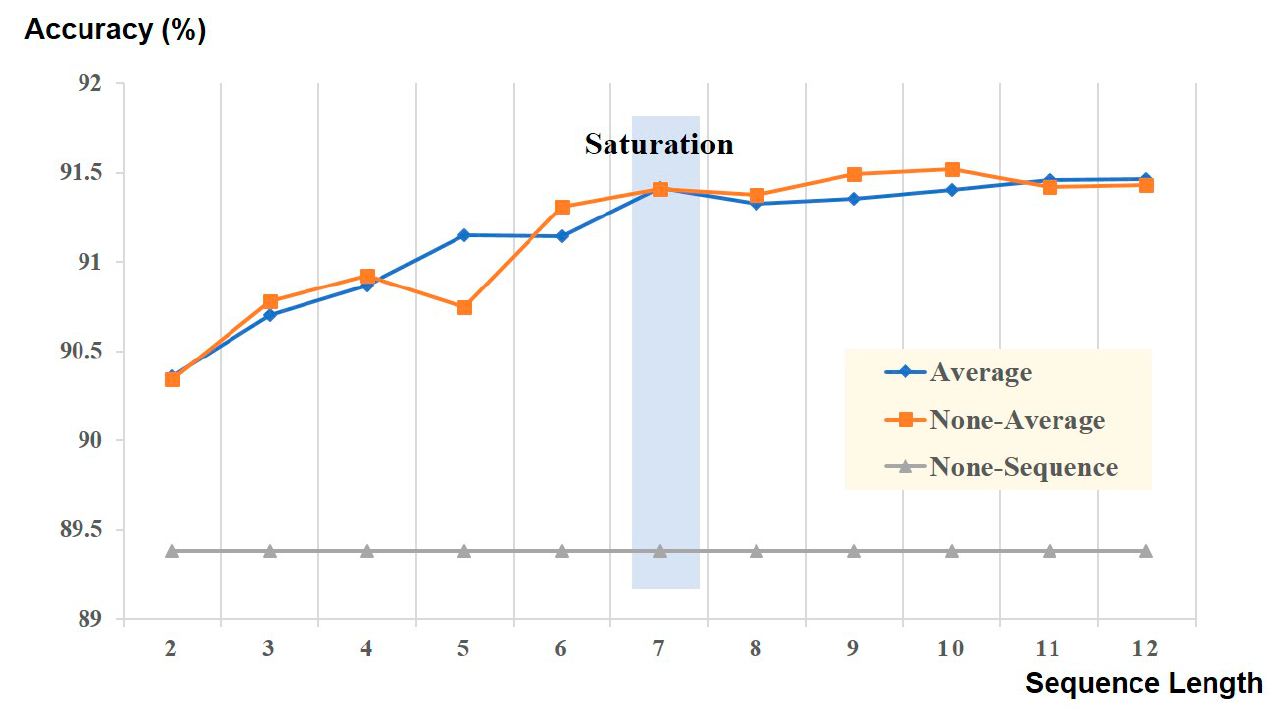
Figure 3. Performance of deep neural network model based on sequence length. The learning curve begins to plateau when more than 7 sequential epochs are used.